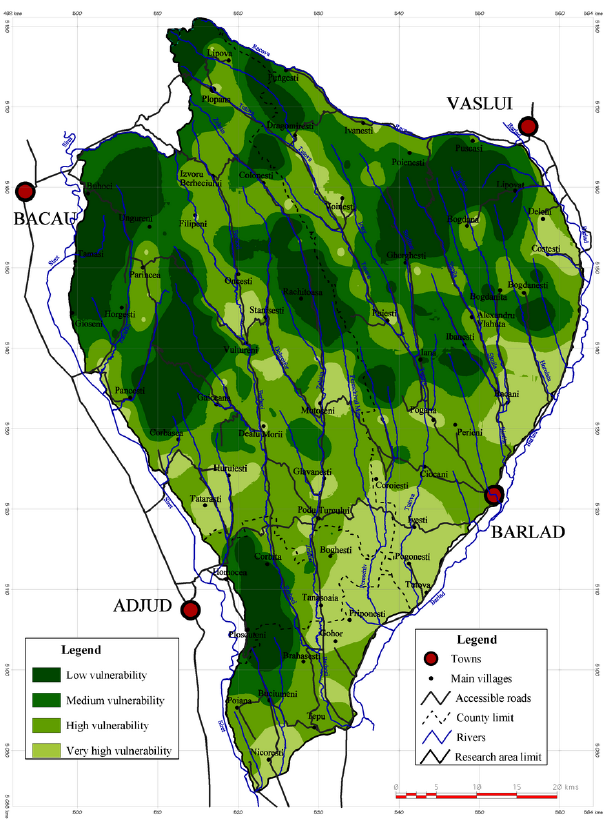
Fig. 7. Vulnerability factor 5: Road accessibility of villages in Tu- tova